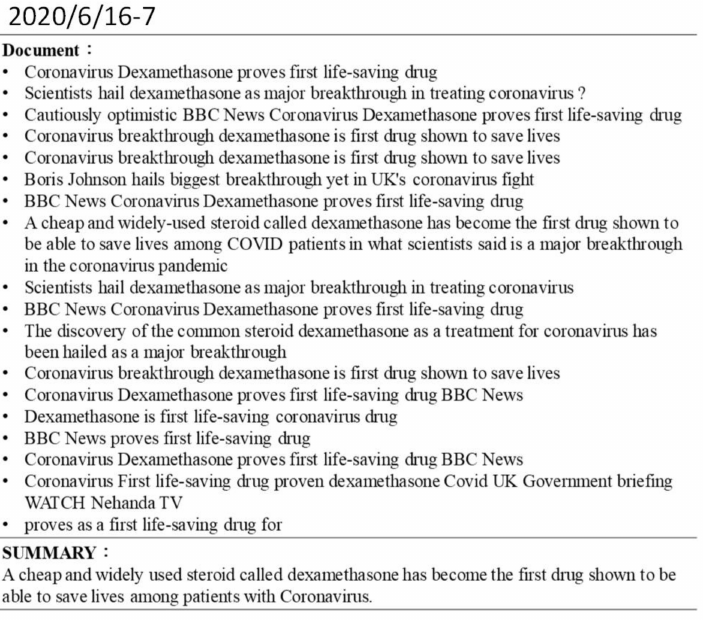
Figure A8. A sample resulting summary of formulated event topics (17 June 2020). Figure A9 shows that on 15 July 2020, in social media, the Center for Disease and Control of the United States called on people to wear masks to effectively prevent the new coronavirus.